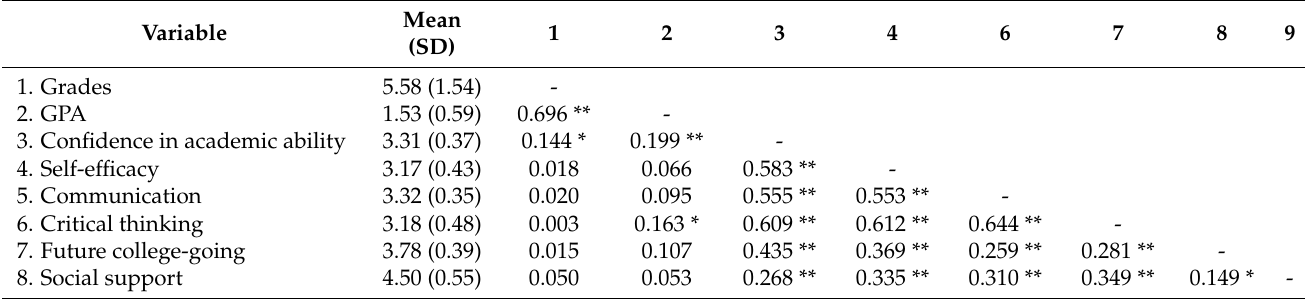
Table 1. Means and correlations among key study